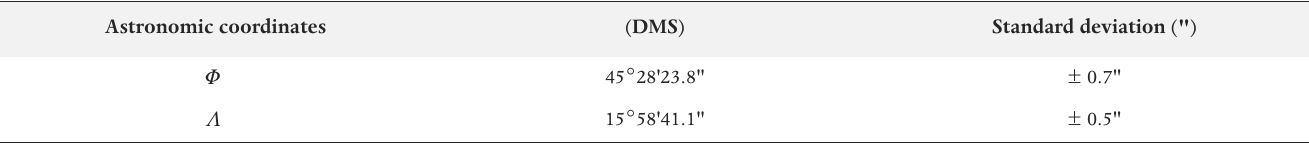
Table 8. Astronomic coordinates of the POKU_SV repeat station.